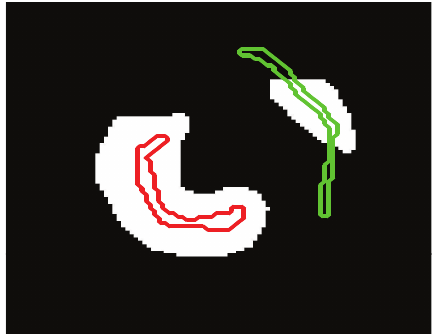
Figure 3: The region of red mask is assigned to the foreground and the green mask is assigned to be the